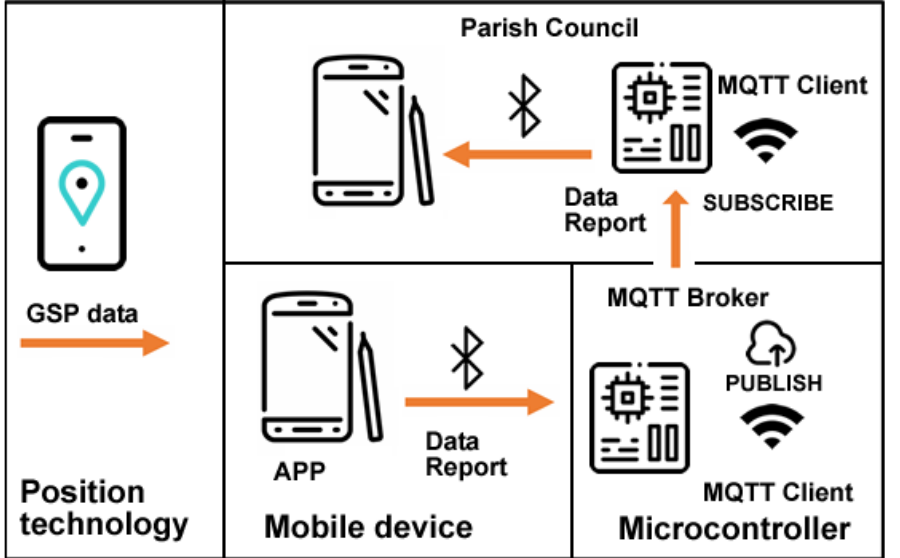
Figure 5. Second proposed system architecture.